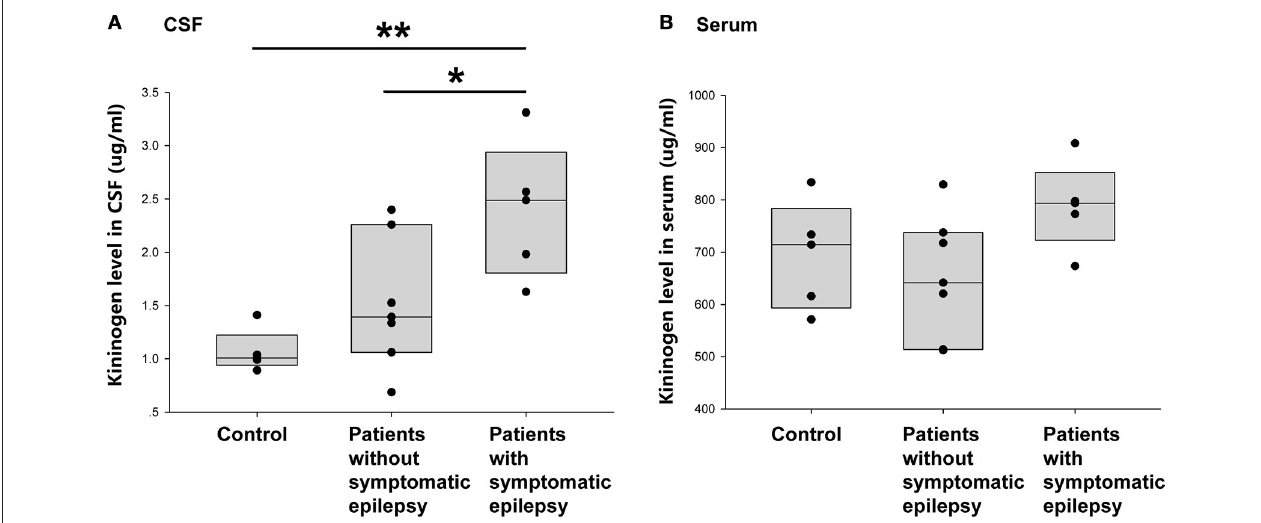
FIGURE 5 | Correlation between post-acute phase CSF and serum KNG protein level and symptomatic epilepsy in 2 years. (A) The level of KNG in CSF of control and encephalitis patients with and without symptomatic epilepsy. (B) The level of KNG in serum of control and encephalitis patients with and without symptomatic epilepsy. * p < 0.05, ** p <